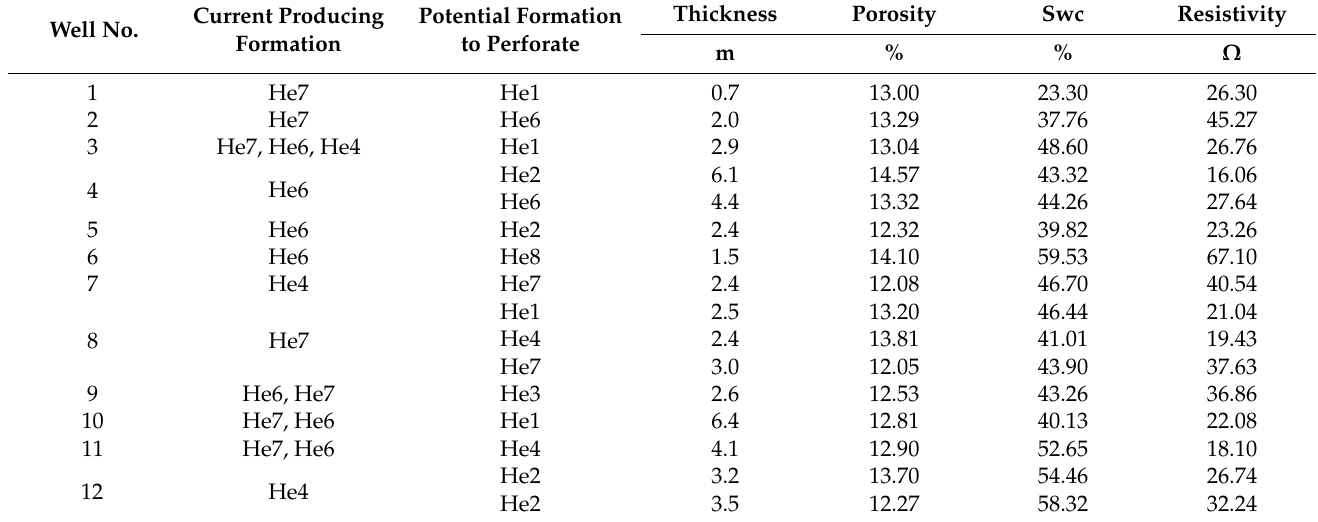
Table 5. Potentials of the 16 reservoir sands for the future perforation of the 12 wells. Well